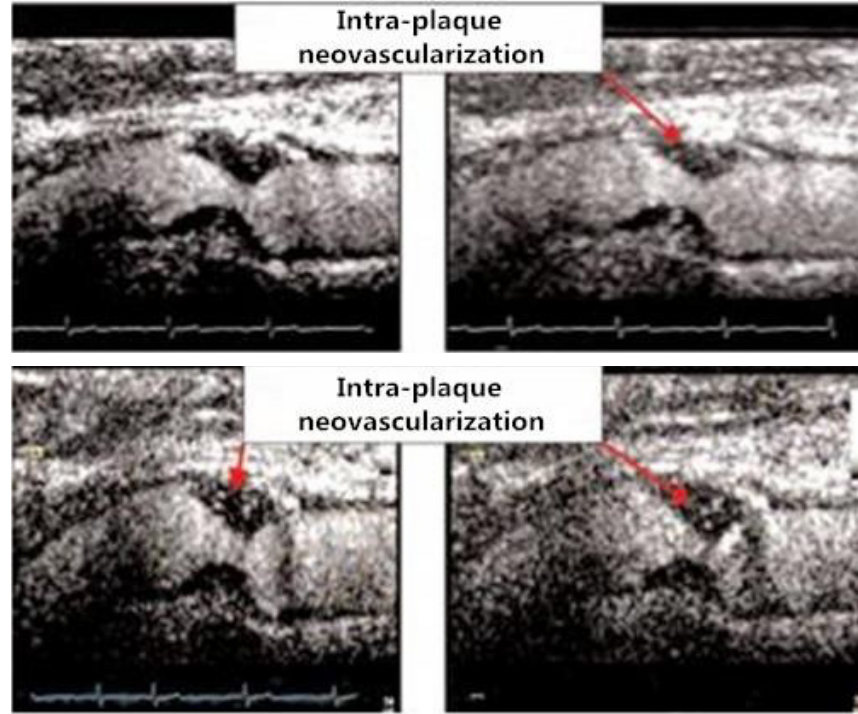
Figure 2 - A sequence of images obtained following the intravenous injection of ultrasound contrast indicates the presence of intra-plaque neovascularization in the sequential frames (Grade 2.5, extensive neovascularization). The presence and degree of neovascularization were determined by surgery and laboratory